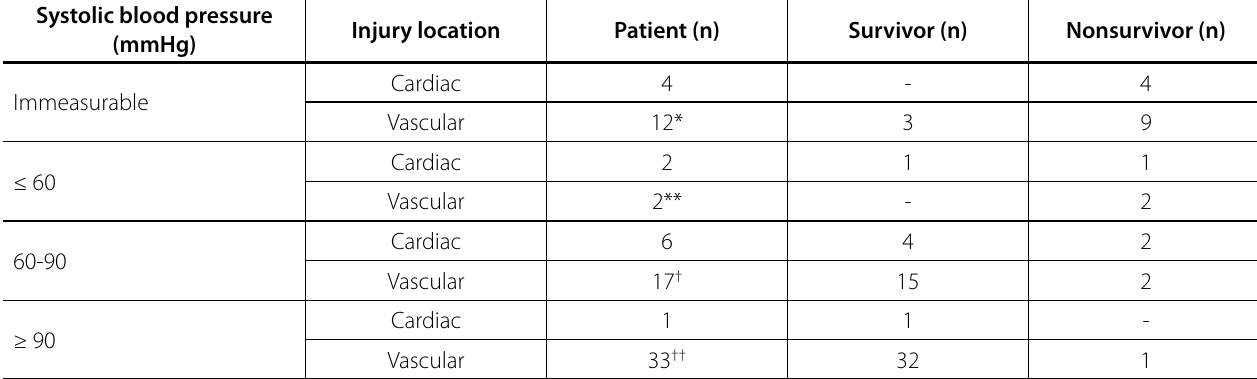
Table 3 . Outcomes of patients according to the measured blood pressures on arrival at the hospital. Systolic blood pressure Injury location (mmHg)